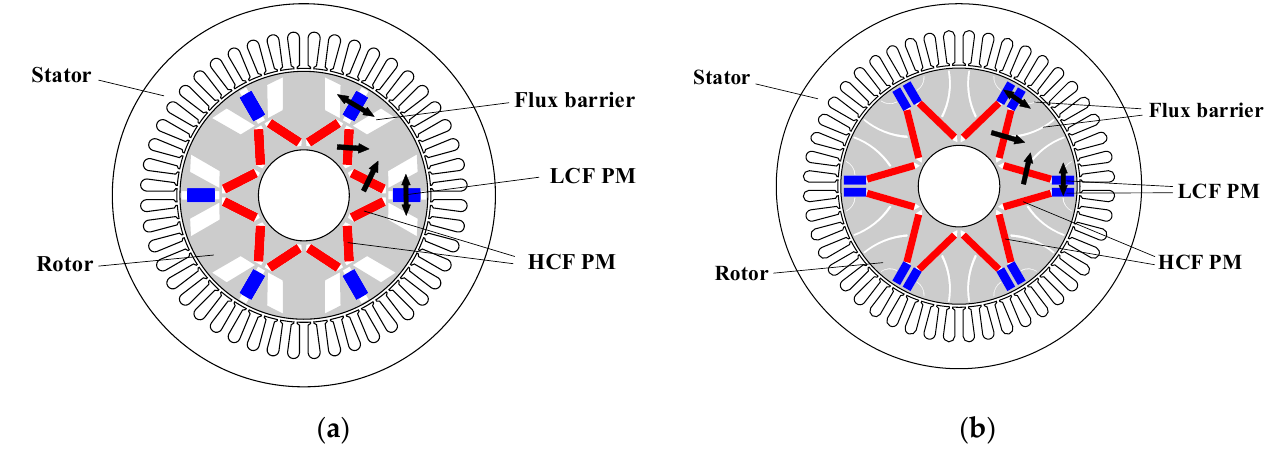
Figure 26. V ‐ type parallel hybrid PM VFM machines. ( a ) Flux barriers close to the air ‐ gap [75]. ( b ) Figure 26. V-type parallel hybrid PM VFM machines. ( a ) Flux barriers close to the air-gap [75]. ( b ) Flux barriers on the main flux path [76]. Flux barriers on the main flux path [76].